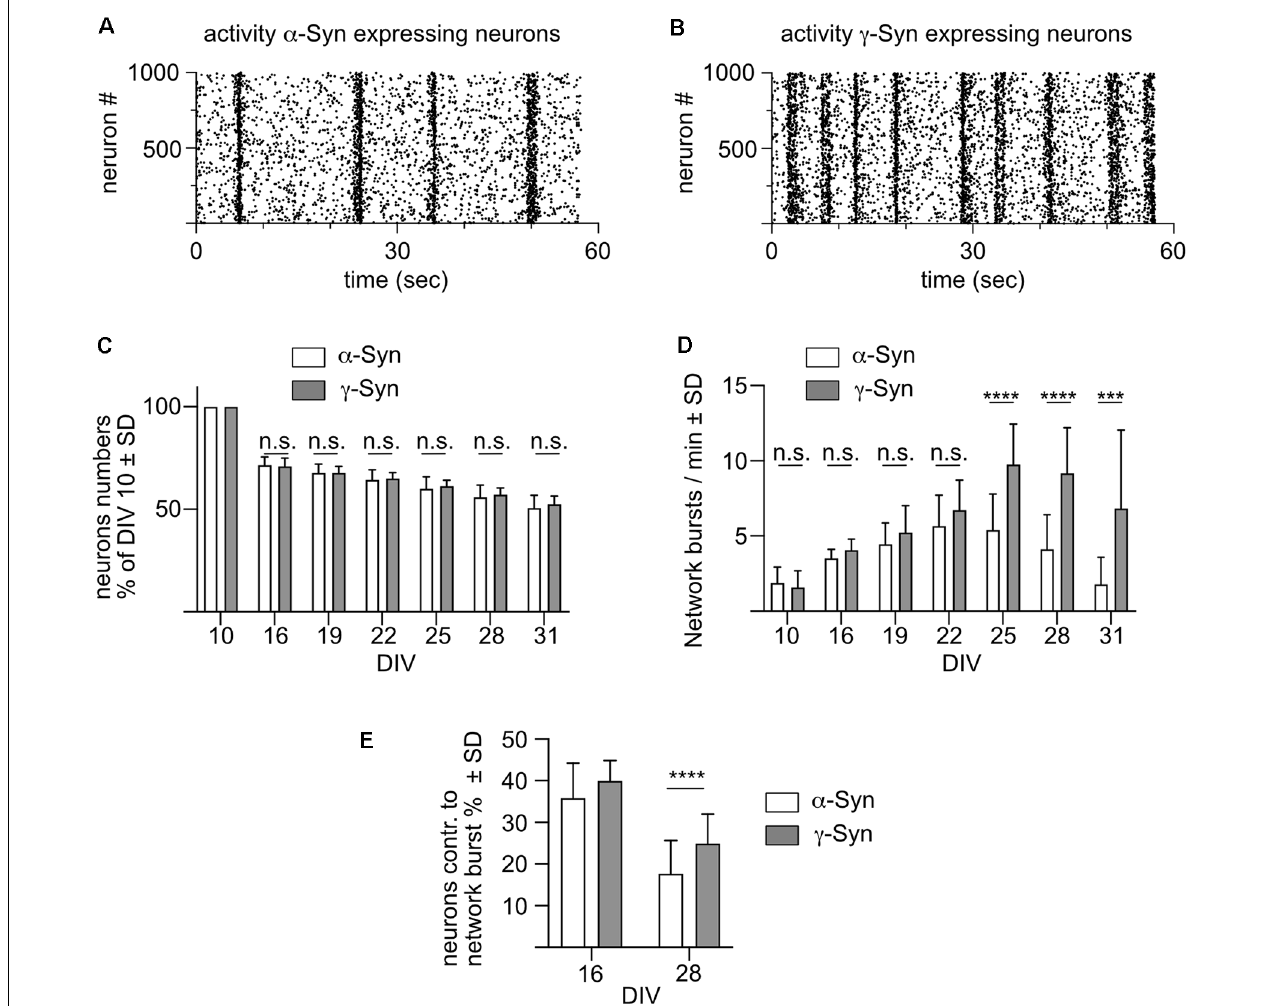
FIGURE 2 | α -Syn reduces network burst activity in aged neurons. (A) Scatter plot showing the activity of 1,000 α -Syn expressing neurons within one minute at DIV 28. Every dot represents the calcium transient of one cell as a surrogate marker for a train of action potentials. Vertical accumulations of this activity represent synchronized network bursts. (B) Scatter plot showing activity of 1,000 γ -Syn expressing neurons at DIV 28. (C) Neuron numbers relative to DIV10 in α -Syn expressing cultures (white bars) and γ -Syn expressing cultures (gray bars). (D) Frequency of network bursts in α -Syn expressing neurons (white bars) and γ -Syn expressing neurons (gray bars). (E) Percentage of neurons contributing to network bursts at 16 and 28 DIV in α -Syn expressing neurons (white bars) and γ -Syn expressing neurons (gray bars). N = 18 neuronal cultures for (C,D) and 41 neuronal cultures for (E) . Statistics by unpaired, two-tailed T-test; n.s. = not